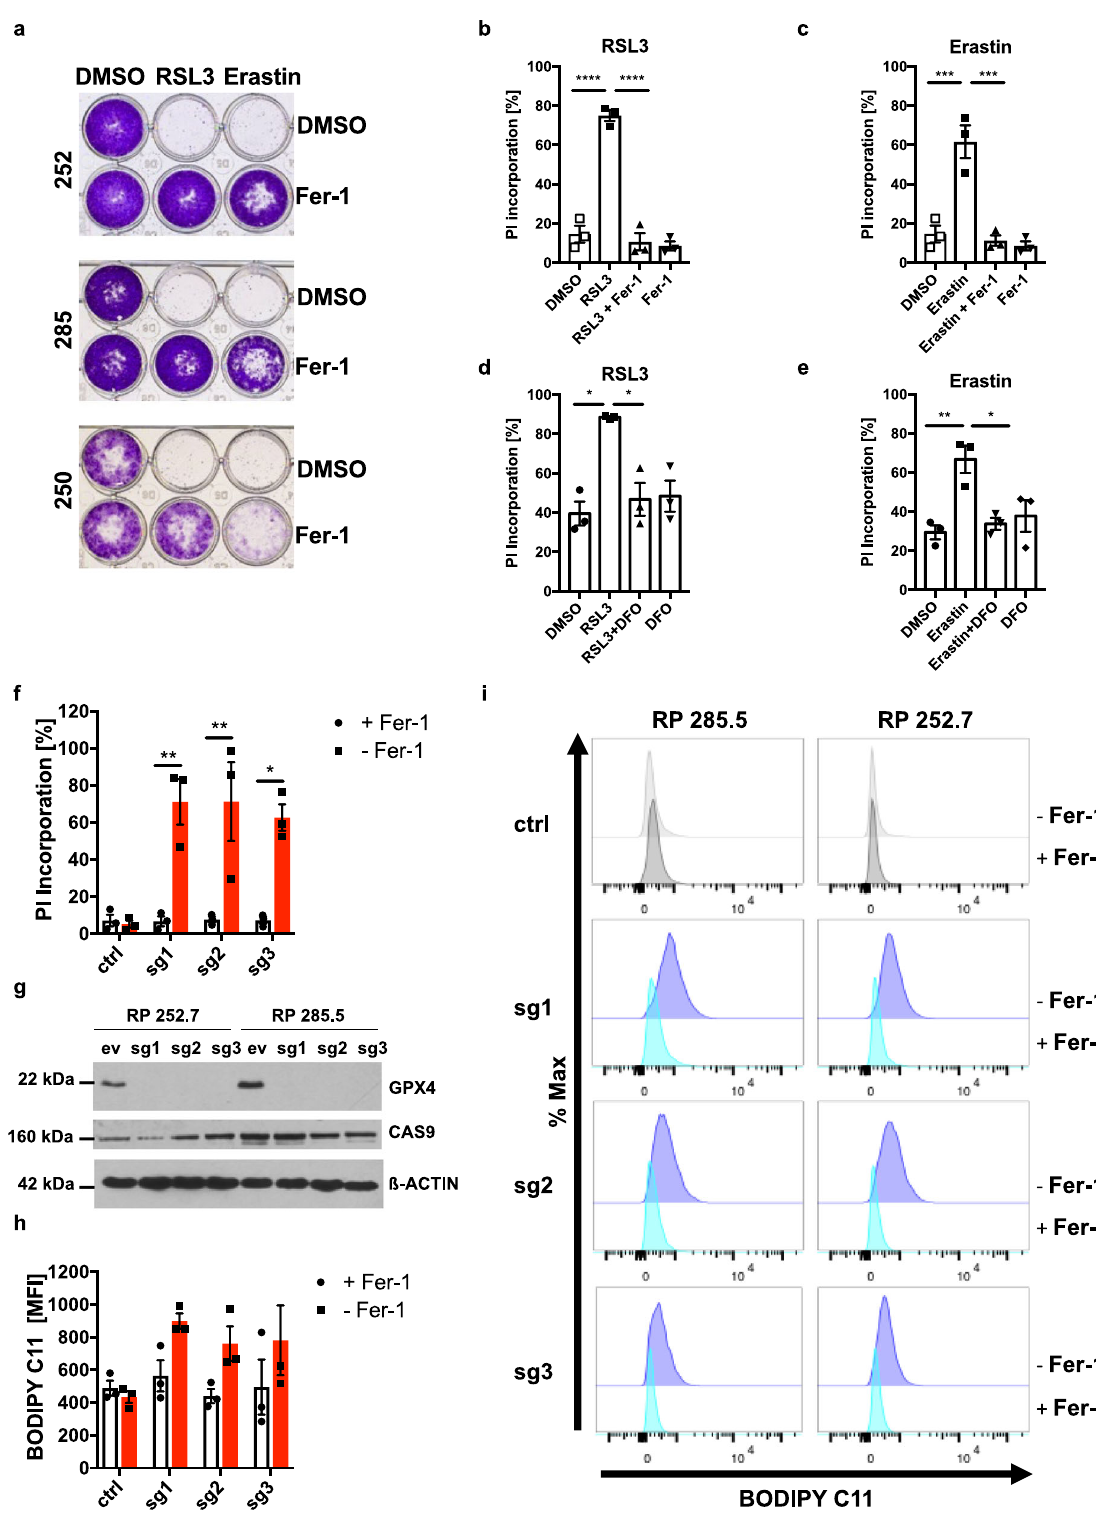
stickers and fl oaters, respectively (Fig. 3g). Strikingly, all isogenic NE fl oaters were indeed more resistant to ferroptosis triggered by GPX4 inhibition, or erastin, while non-NE stickers were highly sensitive (Fig. 3h; Supplementary Fig. 5b). Moreover, fl oaters unlike stickers showed impaired accumulation of lipid ROS and total ROS upon GPX4 inhibition (Supplementary Fig. 5c,